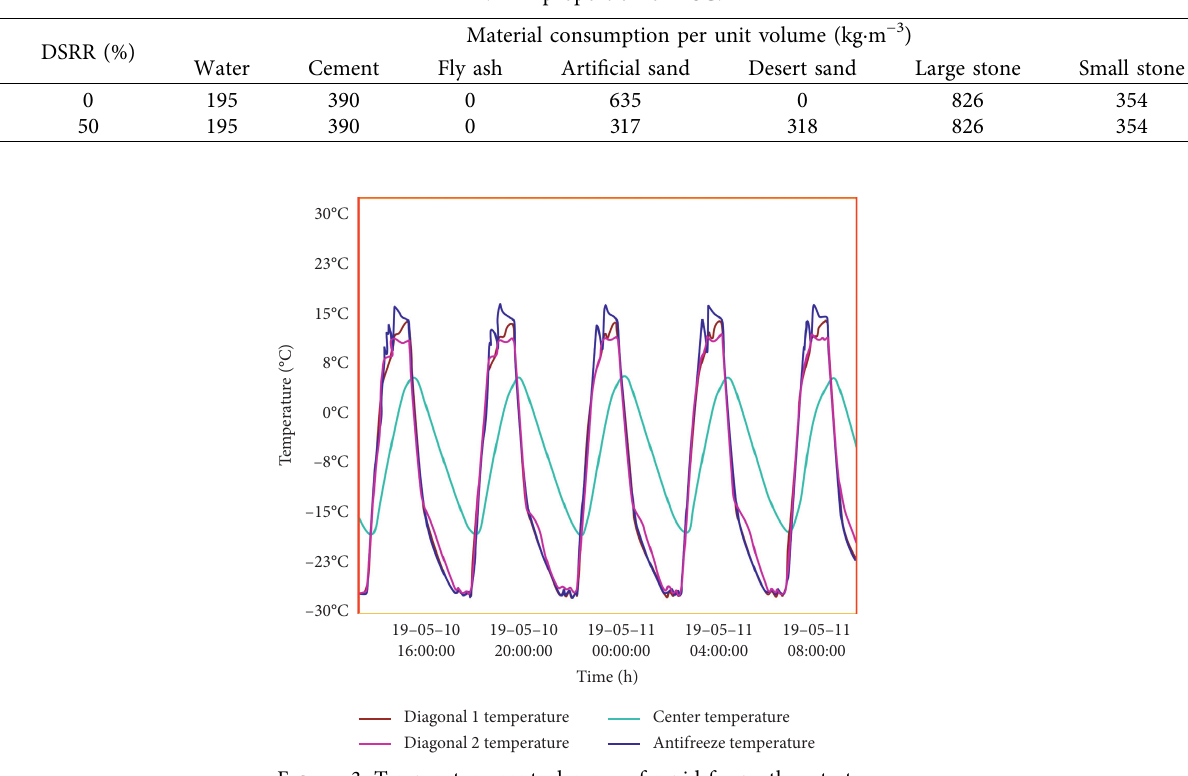
Figure 3: Temperature control curve of rapid freeze-thaw test.